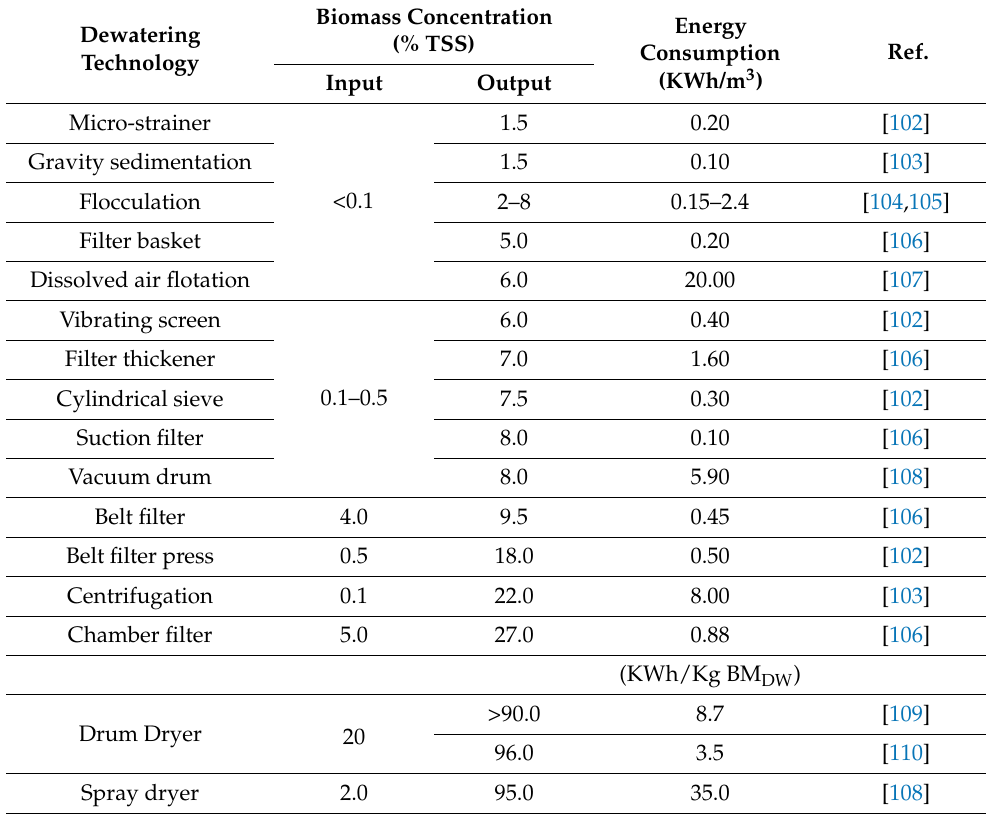
Table 6. Overview of most common dewatering technology associated with biomass concentration and energy